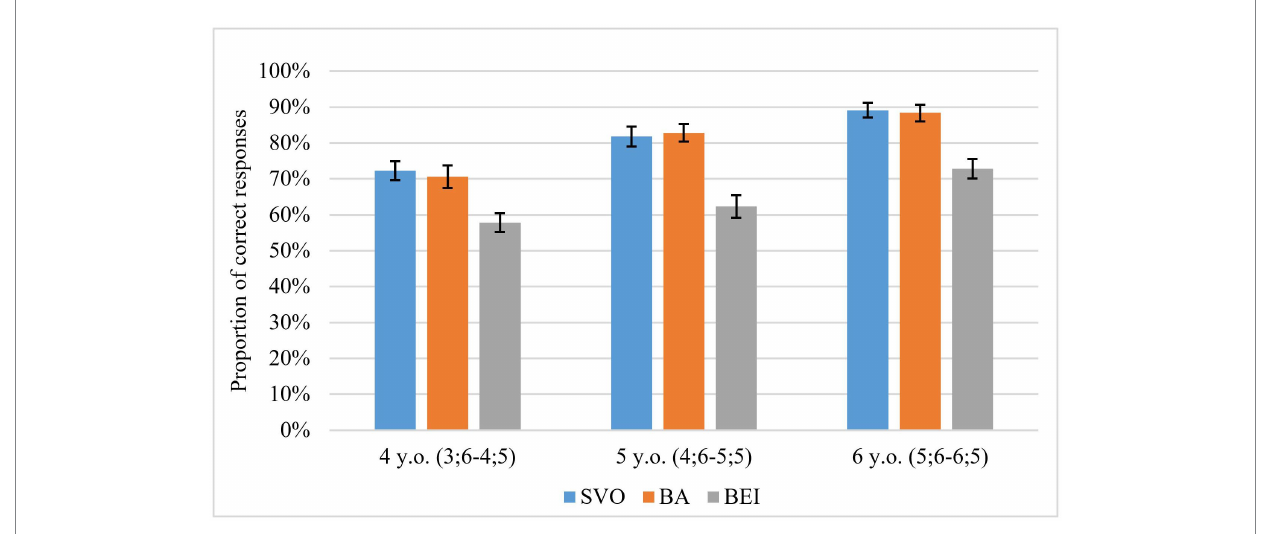
FIGURE 4 Proportion of correct responses in sentence comprehension. Error bars represent ±SEM.